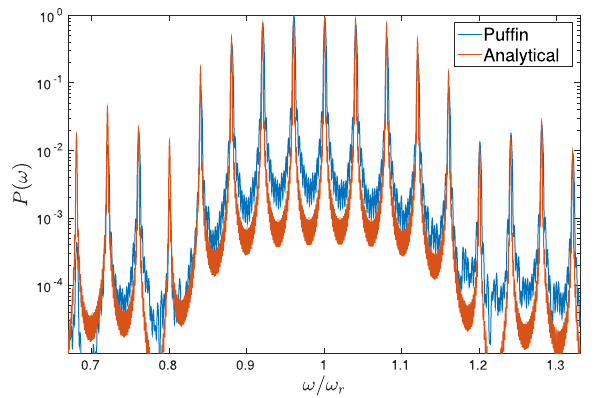
FIG. 5. Comparison of the computational power spectrum obtained from P uffin and the analytical estimate based on Eq. (18). The power spectra are normalized to their maxima. The electron beam has A ¼ 0 . 09 and is run through seven undulator